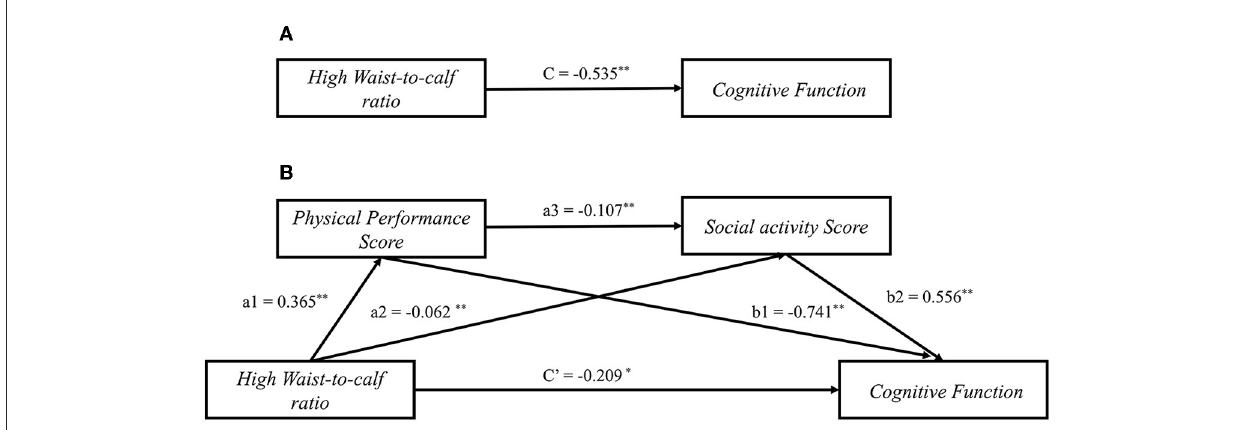
FIGURE1 Mediation models of physical performance and social activity for waist-to-calf circumstance ratio on and cognitive function among Chinese older adults. (A) The total effect of waist-to-calf circumstance ratio on cognitive function; (B) The direct and indirect effects of waist-to-calf circumstance ratio on cognitive function through physical performance and social activity. a1, a2, a3, b1, b2, c’, and c represent standardized regression B-coefficients of the path. * P < 0.05, ** P <